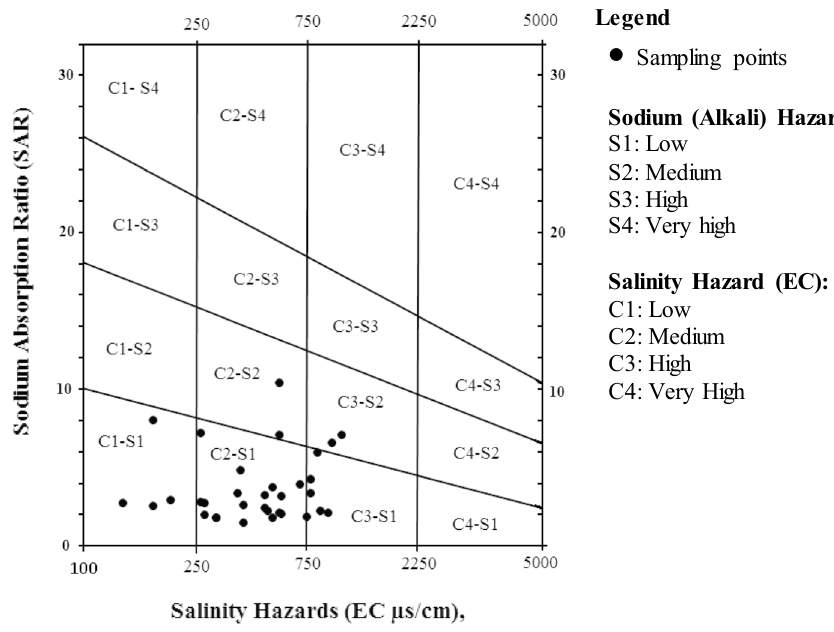
Fig. 8 The USSLS diagram for classification of irrigation water of the study area based on alkali (SAR) and salinity (EC) hazards